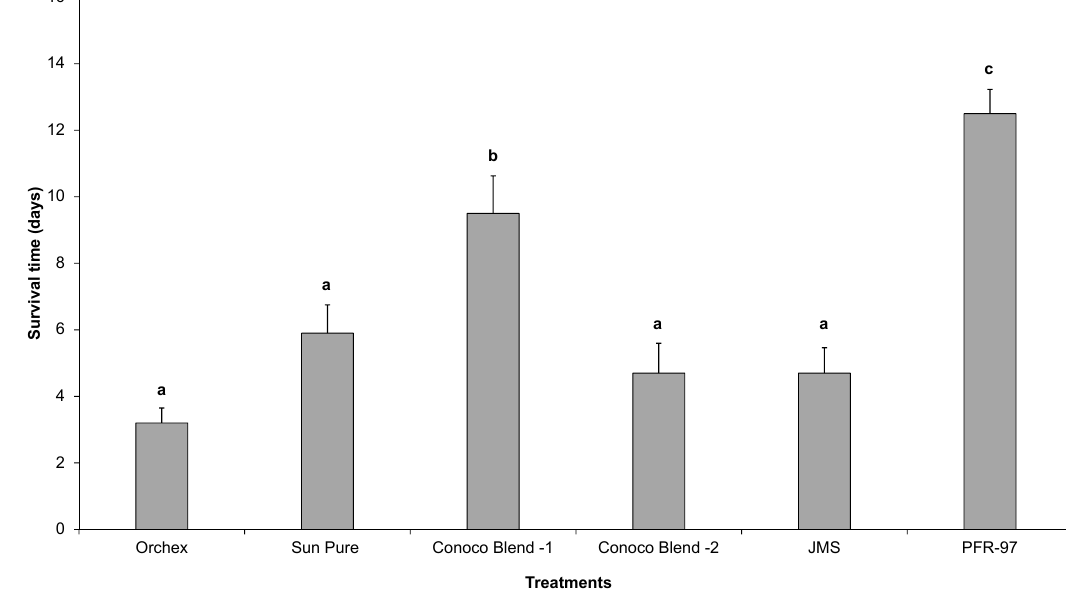
Figure 3. The mean number ( ± SEM) of days’ survival for Diaphorina citri adults after being exposed to Isaria fumosorosea (PFR-97), alone or mixed with different HMOs. Letters located above the SEM bars that are not the same are significantly different (Tukey’s HSD test, p < 0.05).